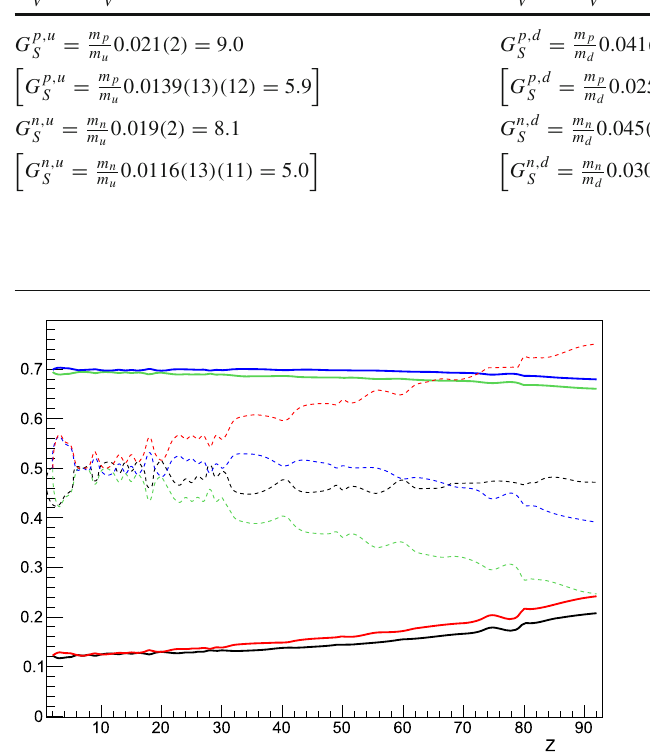
Fig. 5 Normalised quark (solid line) and nucleon (dotted line) overlap integrals as a function of the target charge Z . From the top-down at Z = 90: vector n (red, dotted), scalar d (blue) and u (green), vector p (black, dotted), scalar n (blue, dotted) and p (green, dotted), and vector d (red) and u (black). The nucleon overlap integrals are defined in Eq. (A.5), and those for quarks in Eq. (A.8); an overlap integral for nucleons (or quarks) in target A is normalised by dividing by the the square root of the sum of the squares of all the nucleon (or quark) integrals for